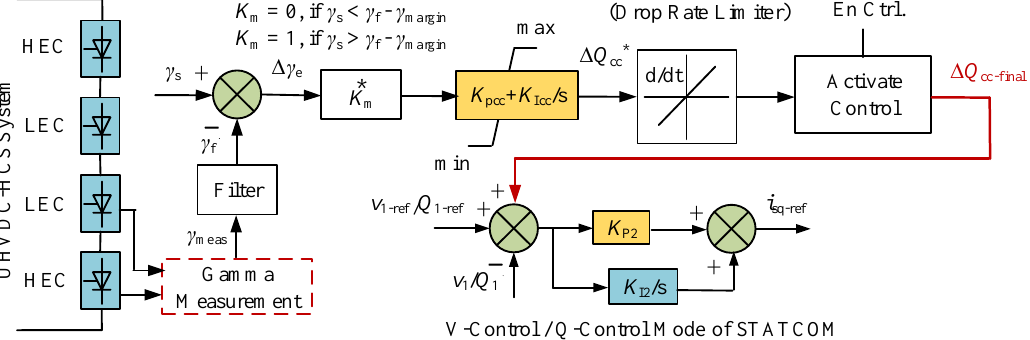
Figure 6. Block diagram for coordinated control between the UHVDC-HCS system and STATCOM.